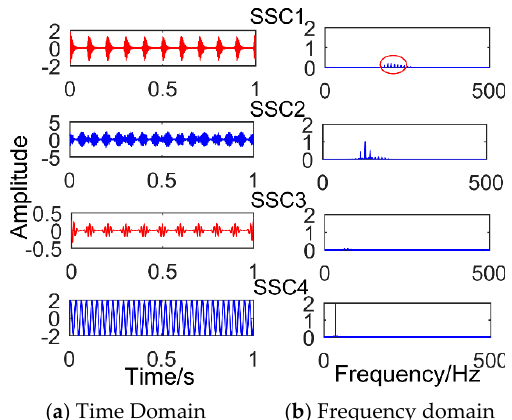
Figure 5. Simulated signal, x1: sinusoidal signal; x2: Modulation signal; x3: periodic impact signal ; and x: Synthetic signal.